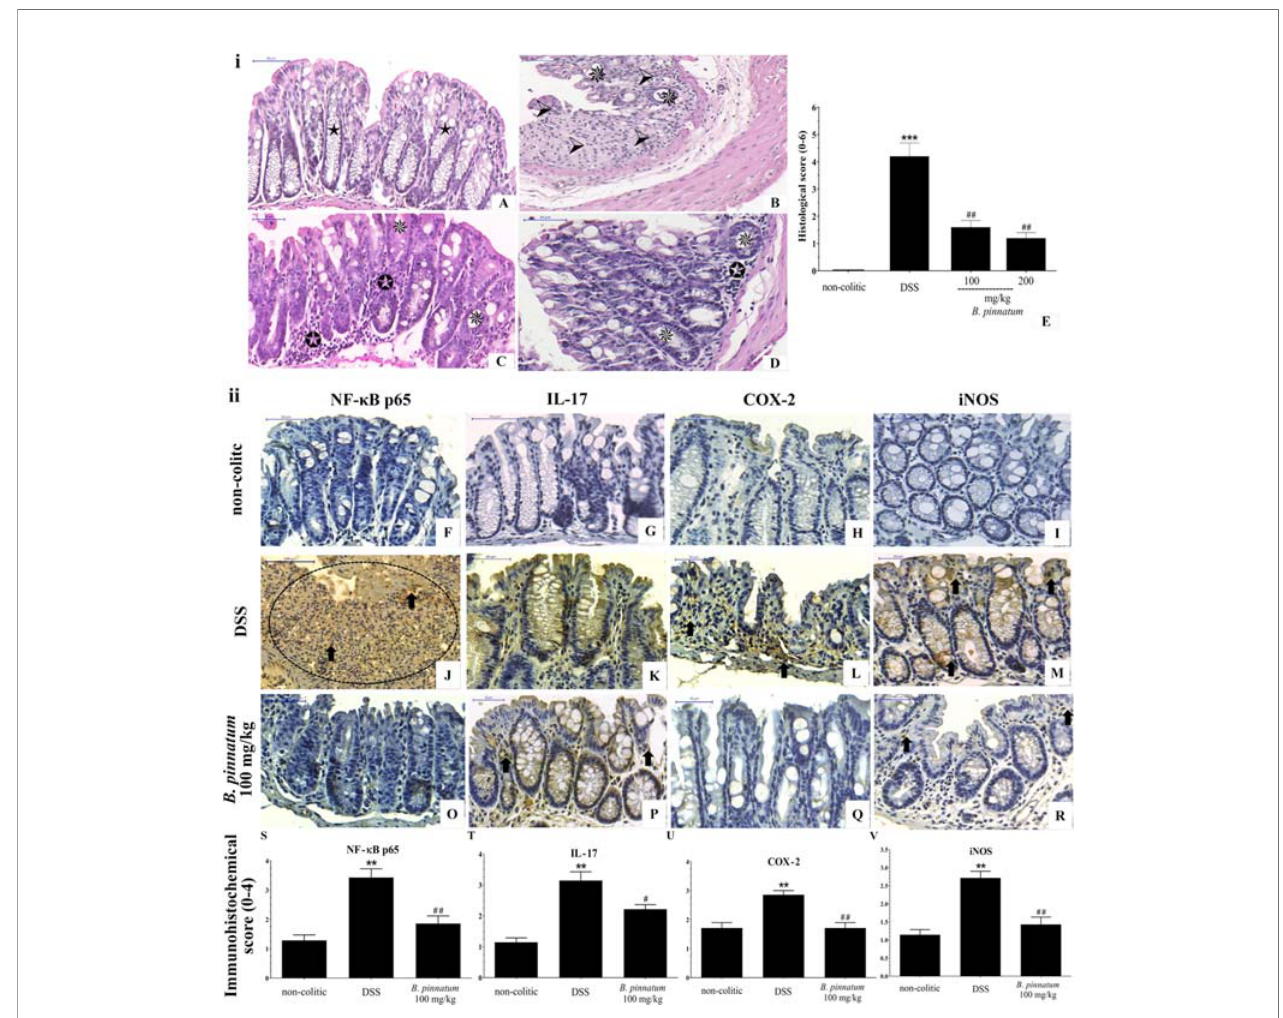
FIGURE 8 | Histopathologic features of representative samples of colonic tissue ( i ), showing the colon fragment cut in the longitudinal direction and stained with Hematoxylin/Eosin; scale 50 m m: non-colitic (A) , DSS (B) , HEBP 100 and 200 mg/kg (C, D) , and the evaluation of microscopic damage (E) . Normal intestinal layers ( ), diffused active colitis with super fi cial erosions, stromal edema, dense acute and chronic in fl ammatory cells in fi ltrate with widely ( ), moderate ( ), light ( ) ulcerating mucosa, and loss of goblet cells ( ). Immunohistochemical analysis of colonic tissue and immunohistochemistry scores ( ii ). Scale bar 50µm. The non- colitic (F – I) , DSS (J – M) , and HEBP 100 mg/kg (O – R) groups were analyzed by immunoreactivity for NF- k B p65, IL-17, COX-2, and iNOS. Arrows indicate antibody reactivity, indicates area of intense in fl ammatory cell in fi ltration, dashed areas indicate ulceration. Data (n = 8) are presented as mean ± standard error from the mean. ** p < 0.01, *** p < 0.001, compared with non-colitic group; # p < 0.05, ## p < 0.01, compared with DSS